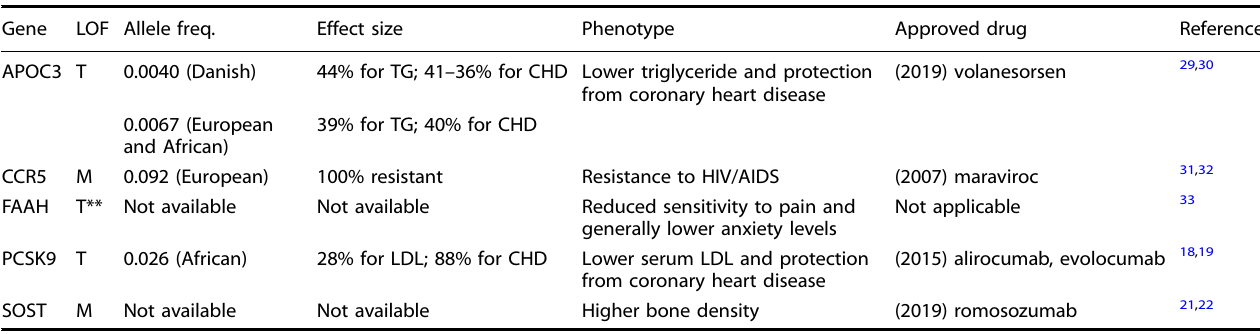
Table 2. Examples of known HKMDs with approved